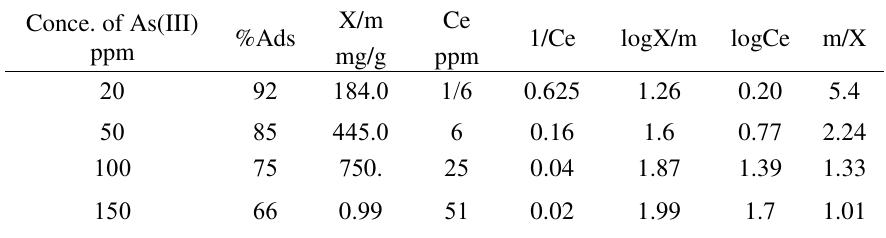
Table 4 Effect of the initial concentration of As(III) ion on adsorption parameters using Freundlich and Langmuir equations